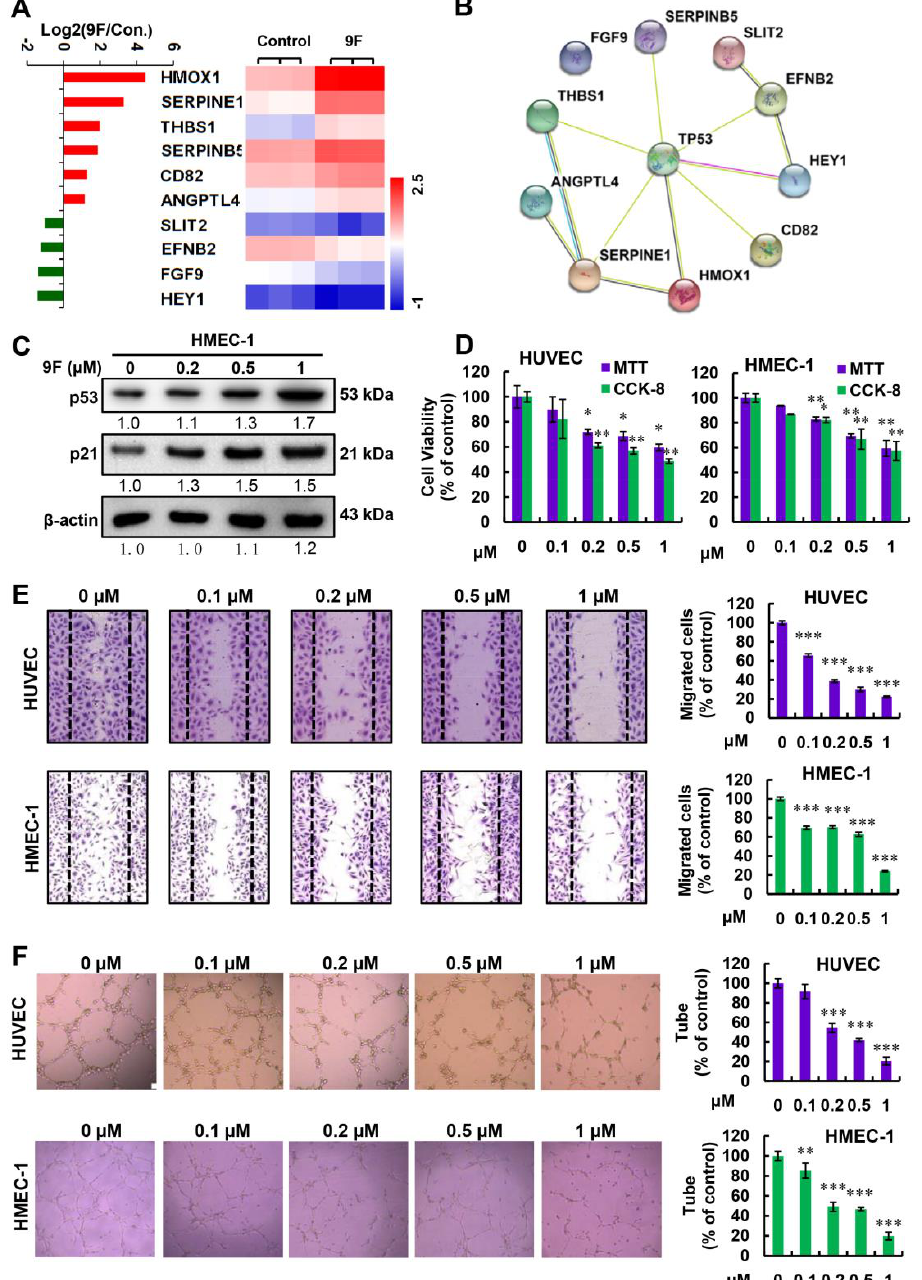
Figure 6. 9F suppressed proliferation, migration and tube formation of endothelial cells. ( A ) The transcript levels of genes related to angiogenesis from RNA-seq data. ( B ) PPI network based on STRING showing the detailed interactions of p53 and the angiogenesis-related genes regulated by 9F treatment. ( C ) Western blot analyses of p53 and p21 protein in 9F-treated HMEC-1 cells. Cells were treated by 9Ffor 48 h. ( D ) Cell viability was measured in human endothelial cells treated with various concentrations of 9F for 48 h. * p < 0.05, ** p < 0.01. ( E ) Cell migration of endothelial cells was analyzed by the wound healing assay (10 × ). *** p < 0.001. ( F ) Tube formation by endothelial cells was